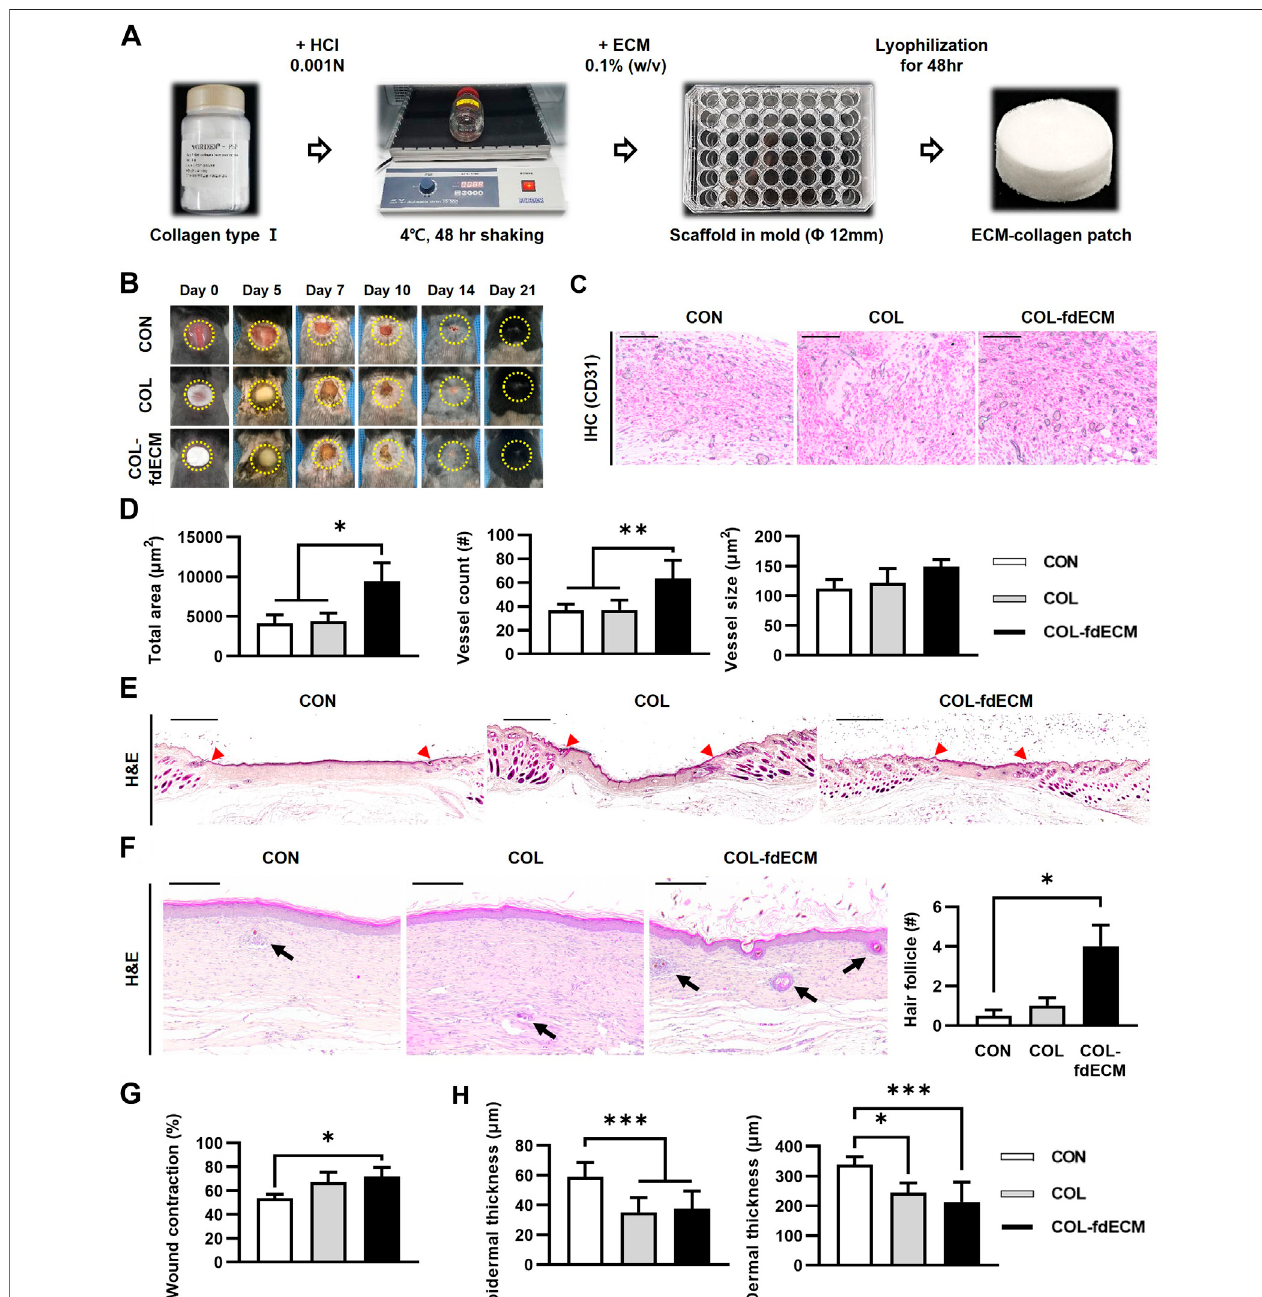
FIGURE2| Invivo evaluationoffdECMscaffoldsonfull-thicknessskinwounds. (A) FabricationoffdECMscaffoldbyaddingcollagenIandlyophilization, (B) Gross evaluation of skin wounds, (C) Immunohistochemistry images stained with anti-CD31 antibody after 7 days of treatment (Gray color indicates a positive reaction), Scale bar represents 200 μ m (D) Semi-quantitative measurement of blood vessel area, count, and size, after 7 days of treatment. (E) Whole-mount image of skin wound stained with hematoxylin and eosin (H&E) after 21 days of treatment. The red arrowhead indicates the initial site of the wound. Scale bar represents 2 mm (F) An increased number of hair follicles on regenerated dermis was detected after 21 days of fdECM treatment. Black arrows indicate hair follicles. Scale bar represents 200 μ m. (G) Wound contraction ratio calculated as ratio of the gap between unaffected tissue to original wound diameter, (H) Thickness of epidermis and dermis. Bar in graphs represents the mean ± standard error of mean (SEM). * p < 0.05, ** p < 0.01, *** p < 0.001.